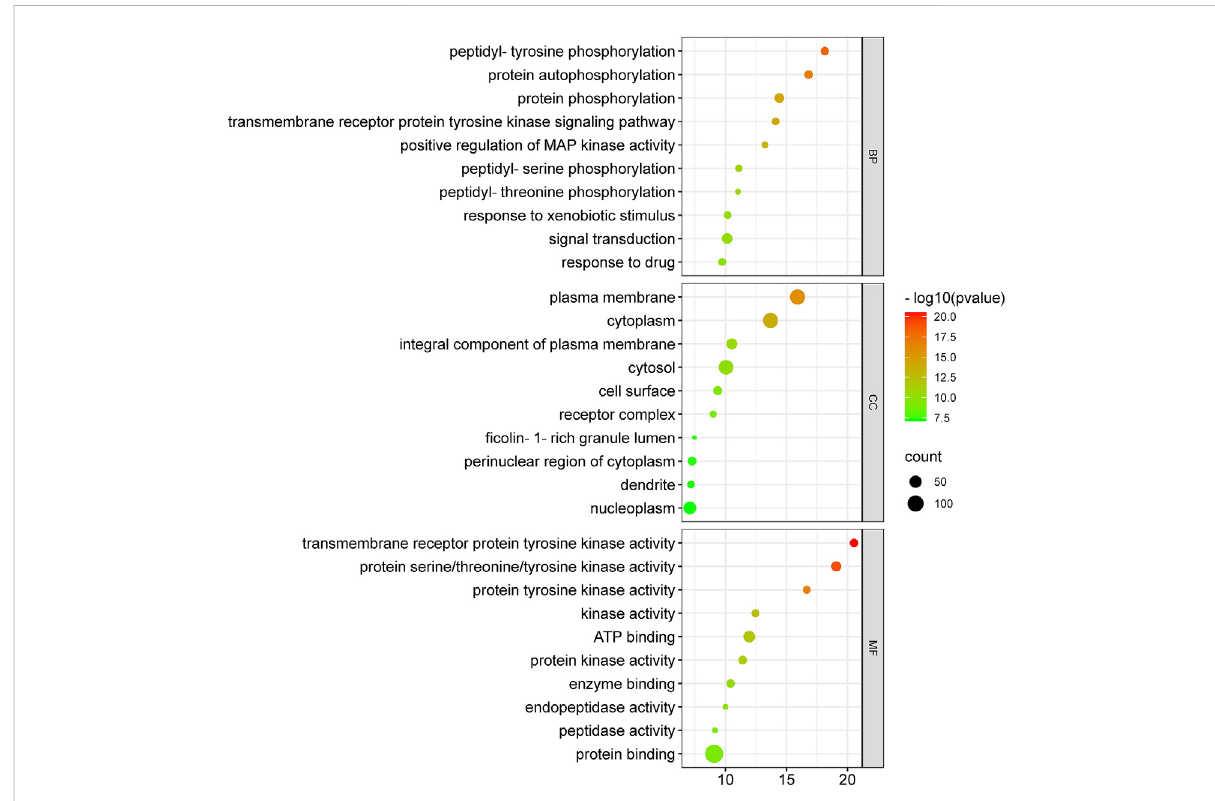
FIGURE 7 Top 10 GO enriched analysis of 153 intersecting targets involved in anti-HCC effects of nitazoxanide drug (GO = Gene